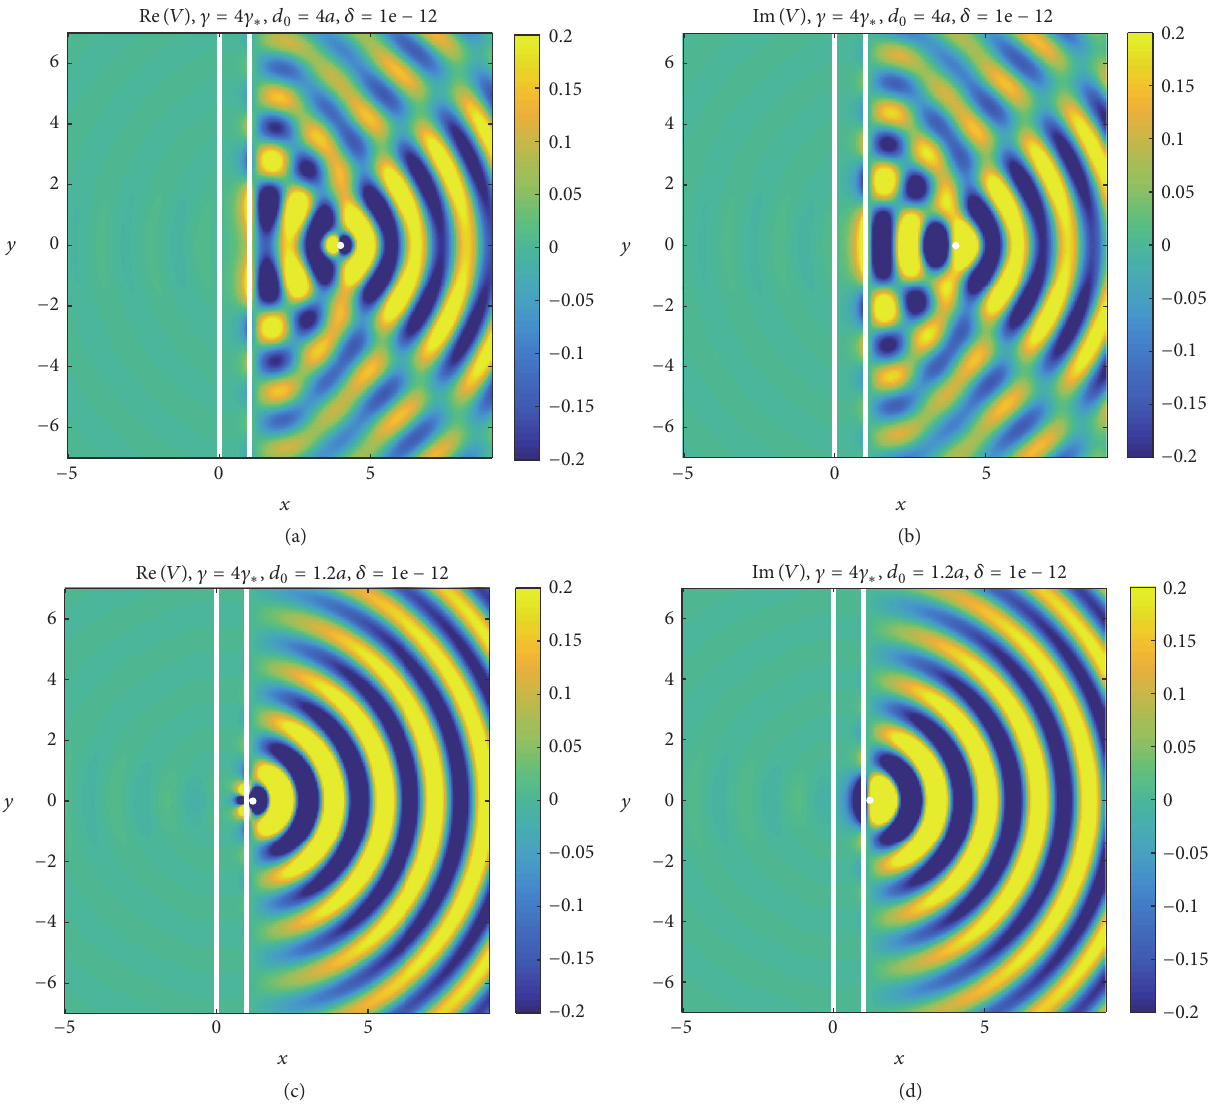
Figure 2: This is a plot of 𝑉 , the solution to (4), when 𝑓 is a dipole and 𝛾 = 2𝛾 ∗ : (a) Re (𝑉) and (b) Im (𝑉) for 𝑑 0 = 4𝑎 ; (c) Re (𝑉) and (d) Im (𝑉) for 𝑑 0 = 1.2𝑎 . To make the behavior of 𝑉 clearer, we clipped the maximum and minimum values in each plot to 0.2 (yellow) and −0.2 (blue),